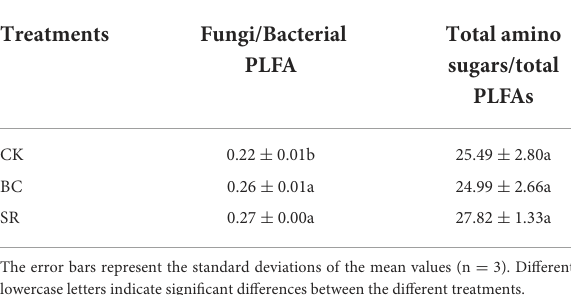
TABLE 7 The ratios of total amino sugars to total phospholipid fatty acids (PLFAs) for different treatments.